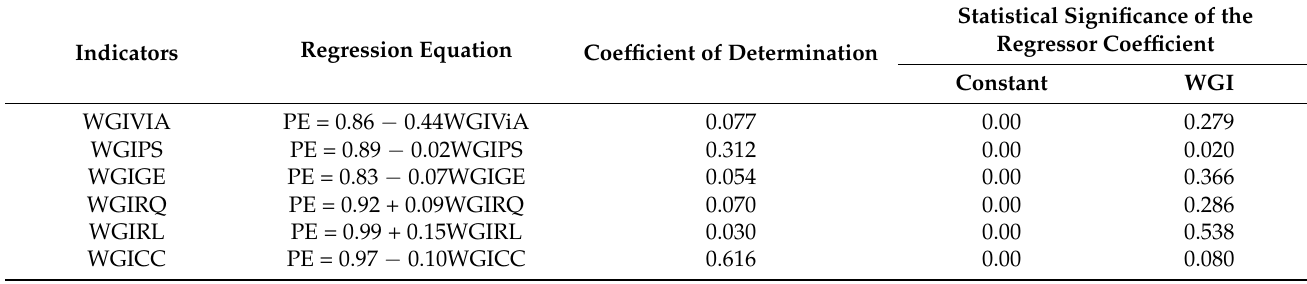
Table 3. Results of the element-by-element assessment of the WGI Impact on the energy efficiency gaps for Ukraine, 2002–2019 (Source: developed by the